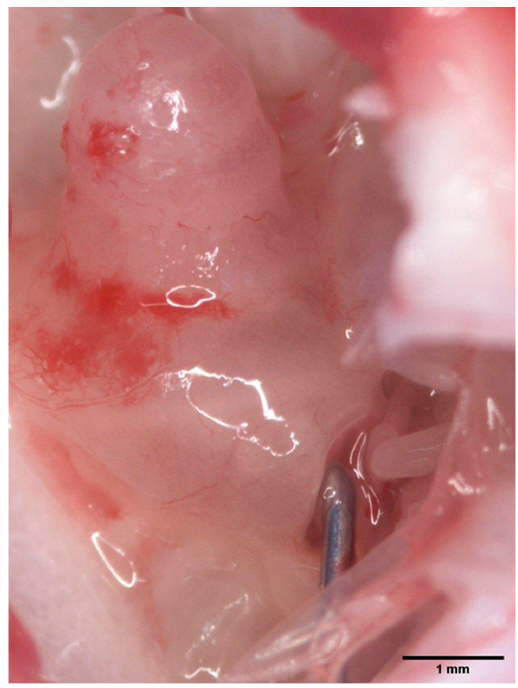
Figure 5. Implanted HDD. Image showing the HDD’s position in the round window. This was investigated macroscopically after euthanasia of the animal and harvesting the bulla. Scale bar indicates